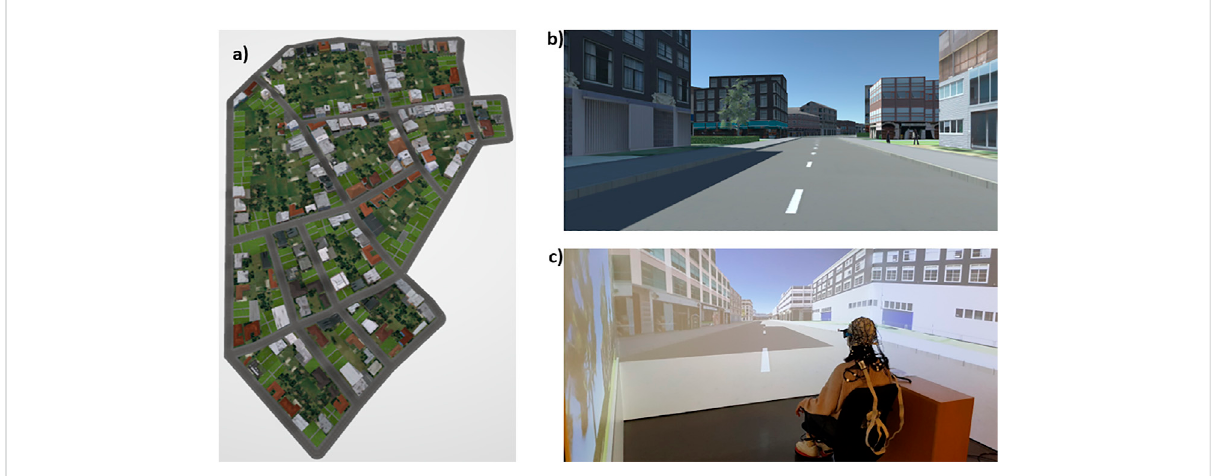
FIGURE 1 (A) Bird ’ s eye view of one of the virtual cities; (B) participants ’ view of the environment during navigation; and (C) a participant wearing stereoscopic goggles, seated on a chair approx. 30 cm away from the center of the VR system (CAVE). The participant placed her feet on a